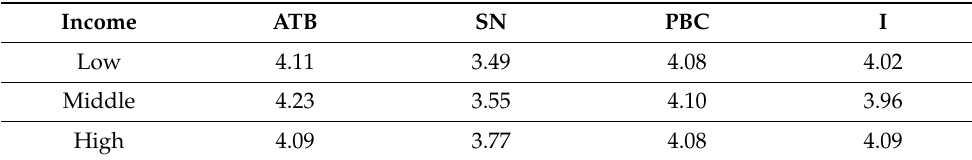
Table 3. Average score of the components of TPB (scale 1–5).